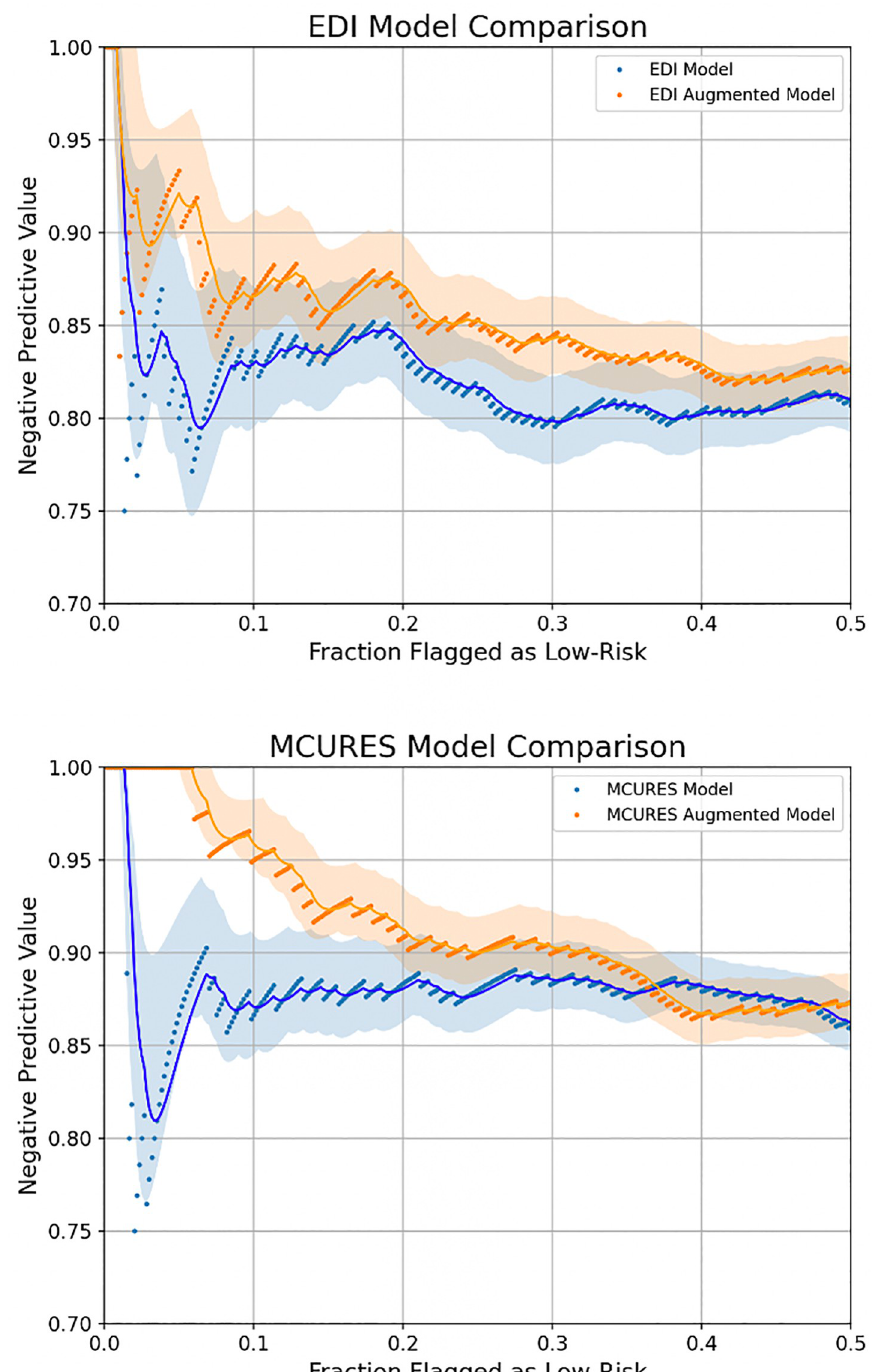
Fig 3. Model predictions for COVID19 positive patients within the first 48 hours of admission, shown with exponential weight moving average and 95% CIs. Each plot shows the number of patients flagged as low-risk by lowest aggregated prediction and the resulting accuracy for that fraction of patients. The top plot compares the EDI augmented model to the EDI model. The bottom plot compares the MCURES augmented model to the MCURES